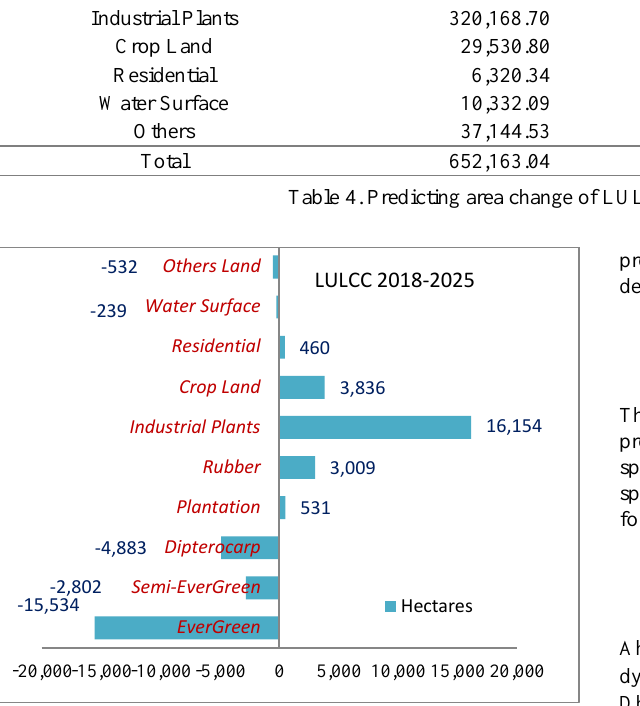
Figure 5. The change prediction in hectares of LULC classes from 2018 to